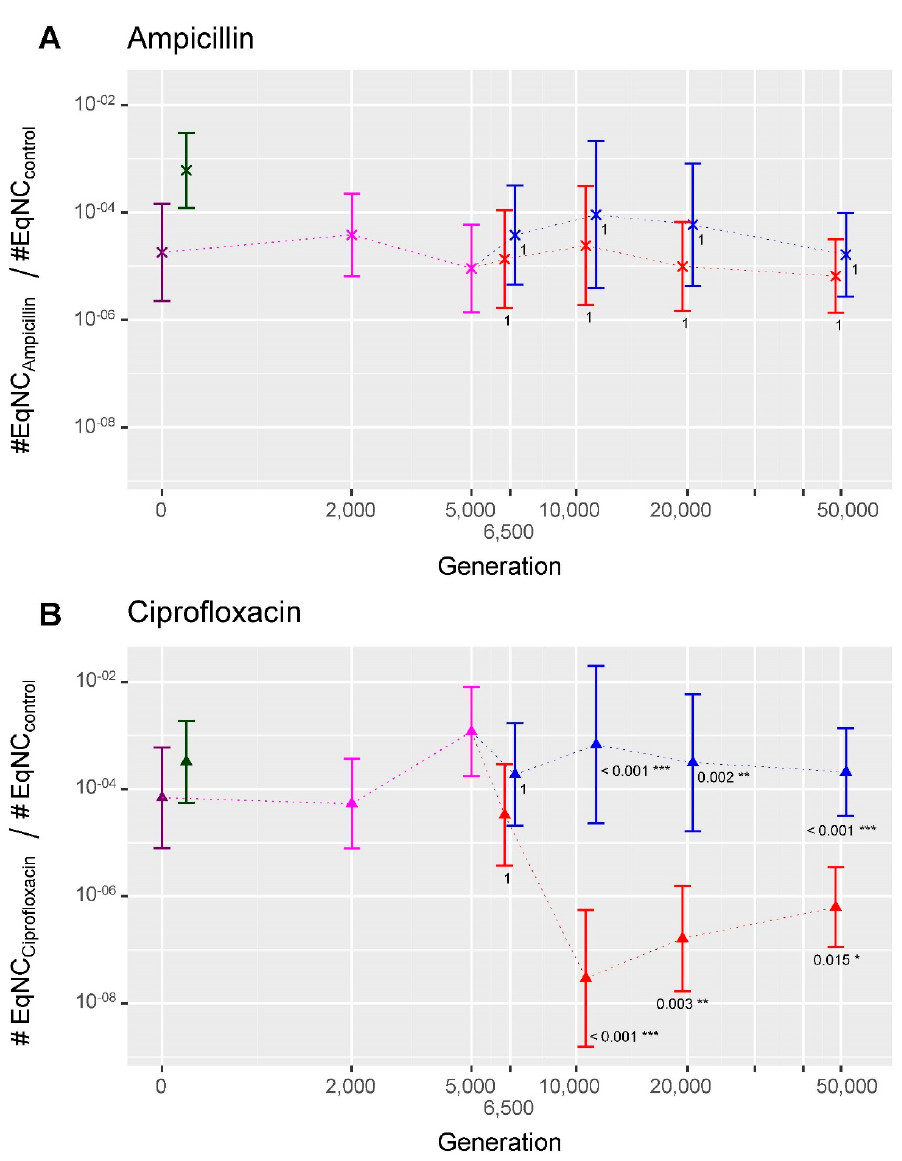
Figure 3. Evolution of persistence to ampicillin ( A ) and ciprofloxacin ( B ) in evolved clones sampled from the Ara − 2 population. Dark symbols represent the ancestor strains REL606 and REL607; pink represent the Ara − 2 evolved clones sampled before the adaptive diversification event; red and blue represent the evolved clones from the S and L ecotypes, respectively. p -values close to the Ara − 2S evolved clones refer to the comparisons to the ancestors, and p -values close to the Ara − 2L evolved clones refer to the comparison between the co-existing contemporary S and L evolved clones. The 95% confidence intervals are shown. Significance codes: 0 ‘***’ 0.001 ‘**’ 0.01 ‘*’ 0.05 ‘.’ 0.1 ‘ ’